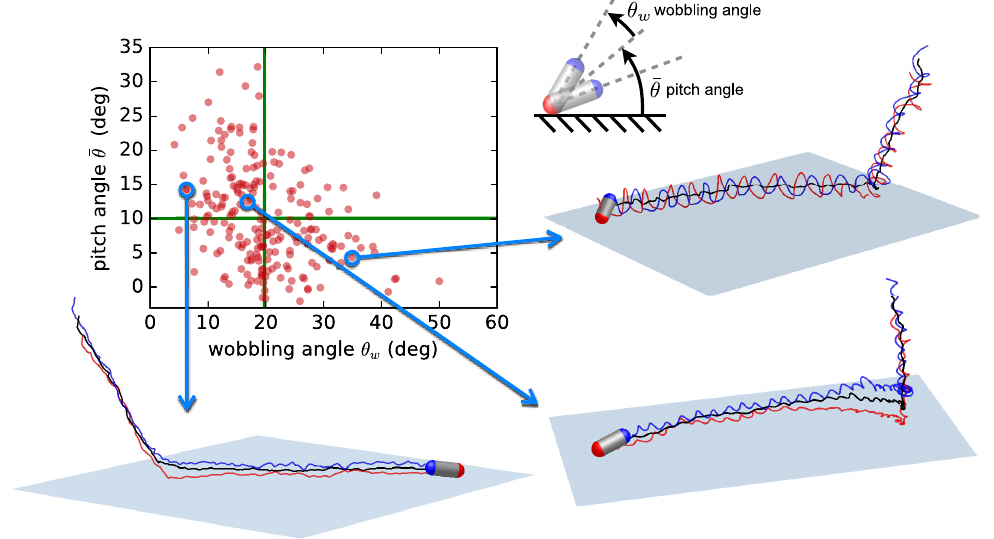
¯ θ FIG. 4. Scatter plot of the time-averaged pitch angle and the wobbling angle θ w for cells that are swimming close to the surface. ¯ θ Green vertical and horizontal lines represent the mean over all the analyzed bacteria. An anticorrelation between and θ w is visible. Three selected cells ’ trajectories with small, average, and large wobbling are also shown. The black line represents the trajectory of the center of mass, while blue and red lines represent, respectively, the back and front